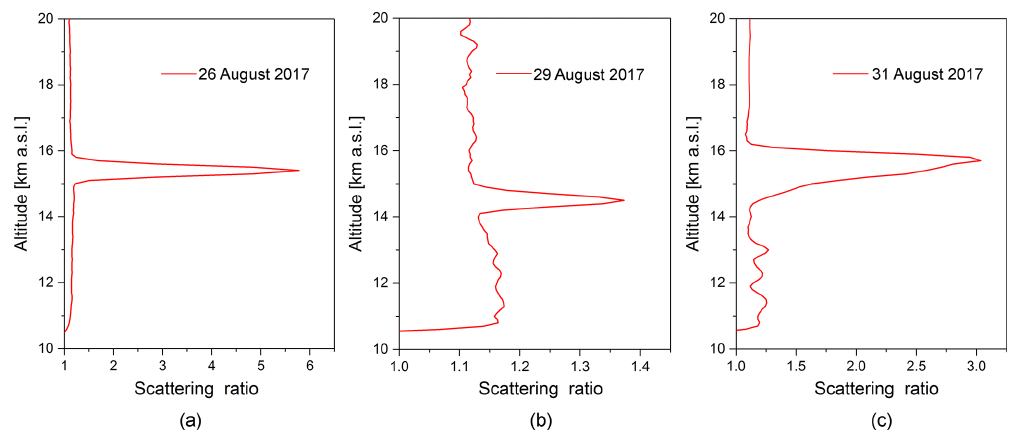
Figure 8. (a–c) Detection of pyroCb plumes from British Columbia in the LS over Tomsk on 26, 29, and 31 August 2017, respectively. Table 1. List of biomass burning plumes with H MPA ≥ 12km that were documented in the Northern Hemisphere and could potentially be detected in the UTLS over Tomsk in the 2004–2011 period. MPA: maximum plume